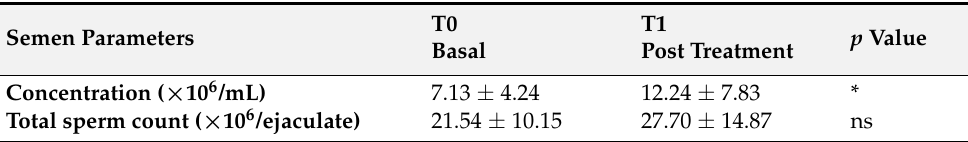
Table 5. Seminal parameters investigated at basal conditions (T0) and after three months of nutraceu- tical administration (T1) (* p < 0.05; ** p <